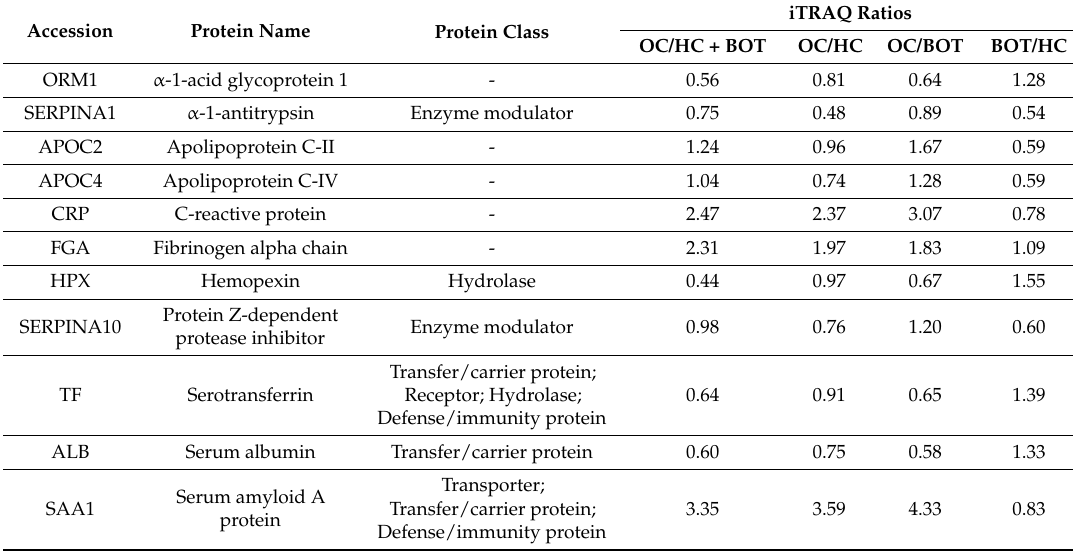
Table 1. ITRAQ ratios and protein class (according to protein annotation through evolutionary relationship (PANTHER) database) of the differently expressed proteins.